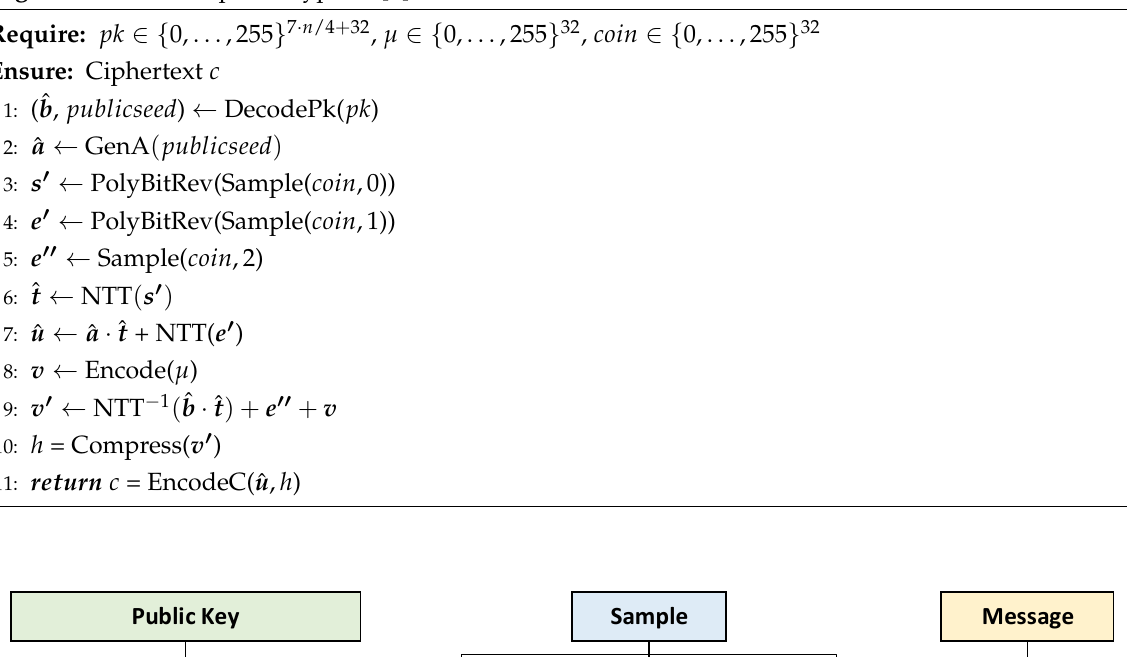
Algorithm 2 NewHope Encryption [9].